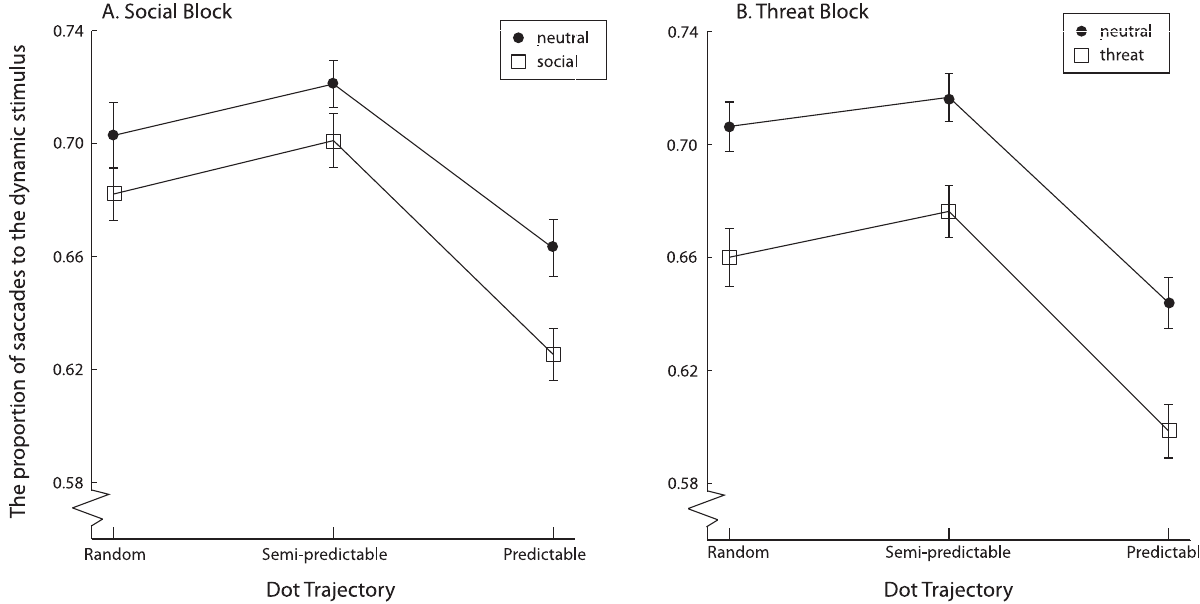
Fig 5. The proportion of saccadesto the dynamic stimulus, separately for the neutral and non-neutral (social or threat, depending on the task) stimuli. Error bars denotewithin-subjects 95% confidenceintervals.